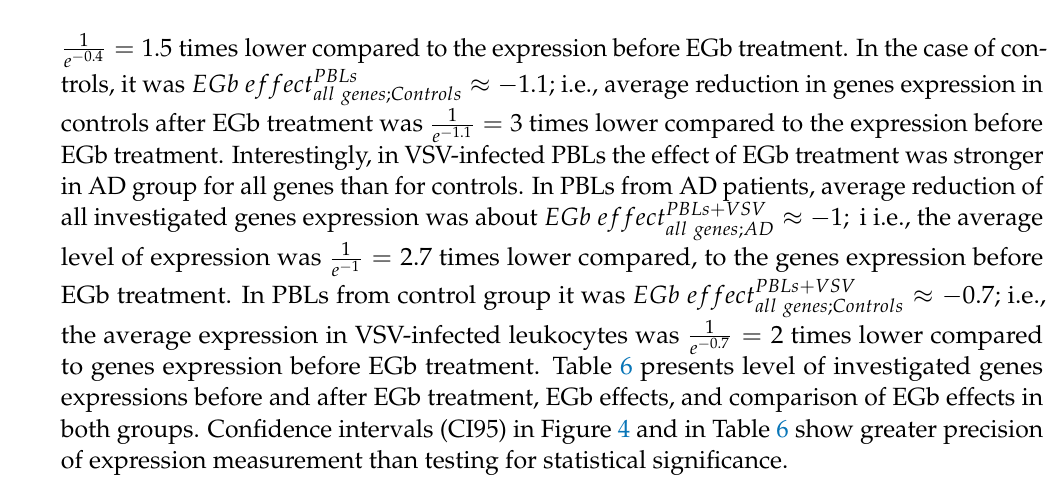
= log ( after ) − log ( before ) . before expressed in logs. before